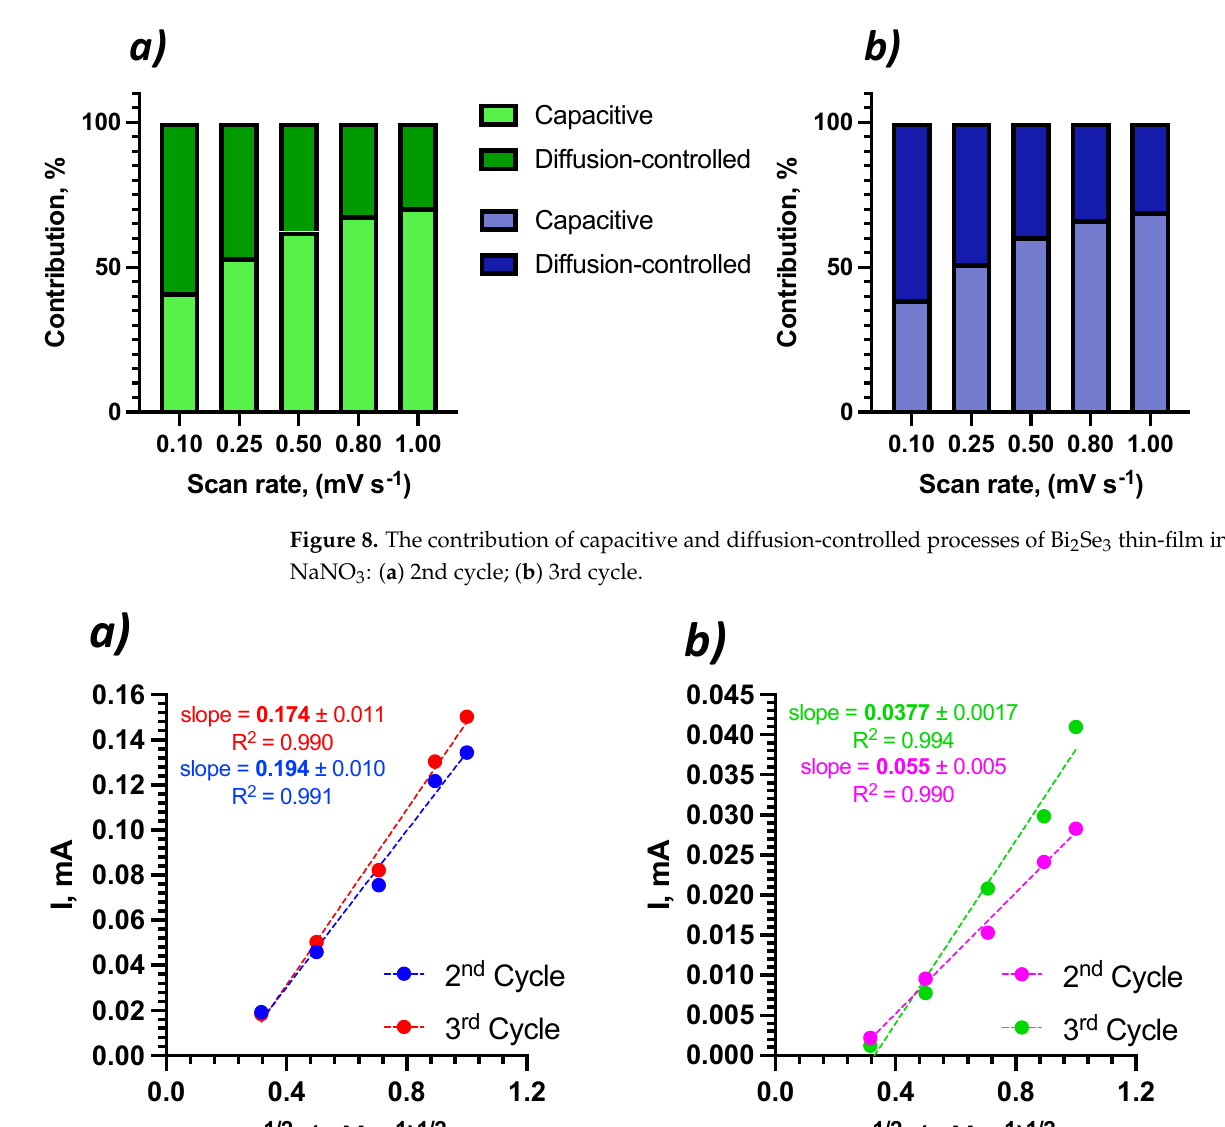
Figure 9. The dependence of v 1/2 vs. I of Bi 2 Se 3 thin film in 1 M NaNO 3 in the 2nd and 3rd cycles with fitted slope values for ( a ) Na + intercalation and ( b ) Na + deintercalation.